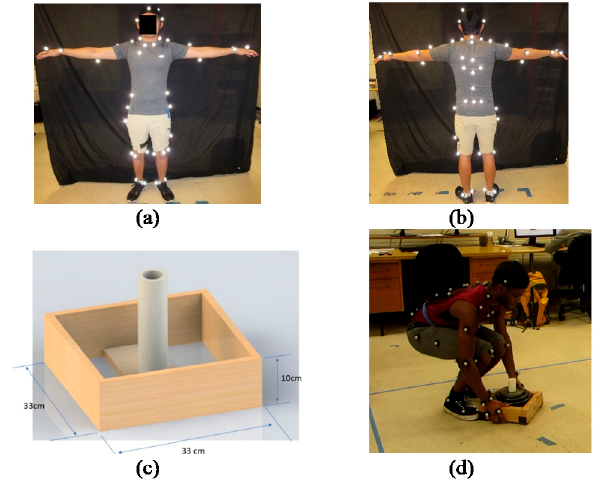
Figure 2. Experimental setup: ( a ) marker placement protocol front view; ( b ) marker placement protocol back view; ( c ) box dimension and weight, without external load: 2.36 Kg, with external load: 10.16 Kg; and ( d ) experiment environment, where the average distance between initial and final position is 2.4 m and the table height of the final position from ground is 0.5